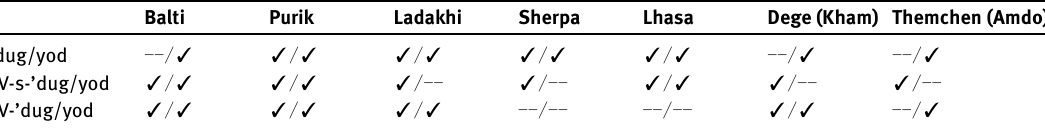
Table 1: The gross distribution of the existential copulas in Tibetan dialects Balti Purik Ladakhi Sherpa Lhasa Dege (Kham) Themchen (Amdo)